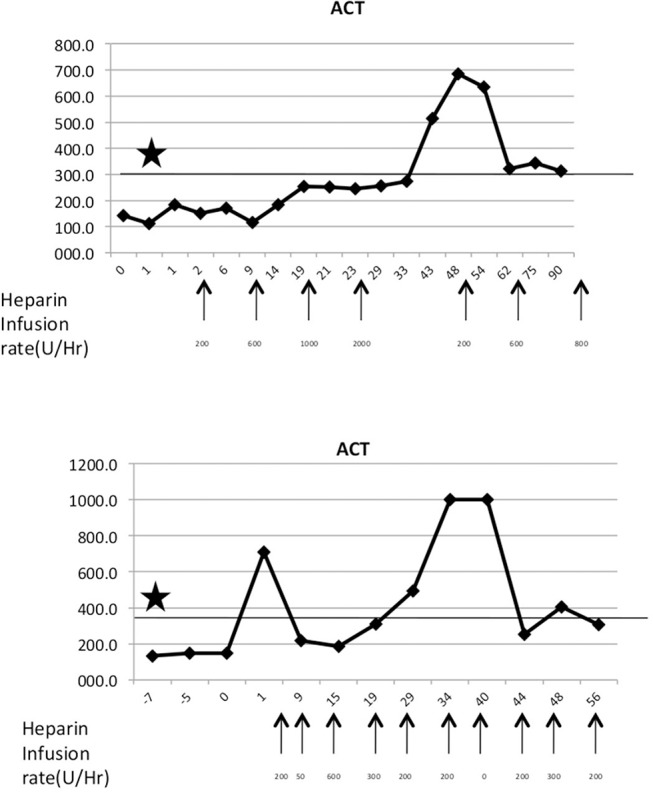
Maintenance of hypercoagulable state. (Top) Baboon with a hypercoagulable state with heparin dosages indicated by arrows. Asterisks denote target ACT levels. (Bottom) A normal baboon with episodic ACT hikes.